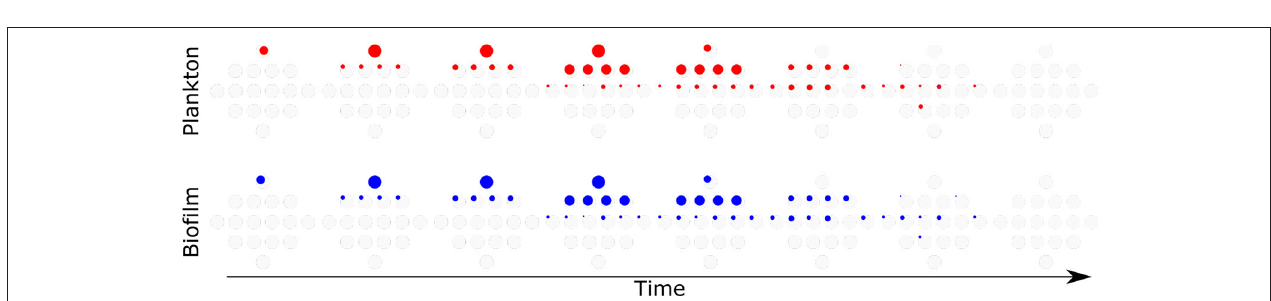
FIGURE 10 | No attachment and dispersal. Red—plankton, Blue—biofilm. From left to right—time, population composition is analyzed every 24 h. The diameter of the colored circle is proportional to the log 10 size of the population. Light gray circles are placeholders for various genotypes, with a diameter corresponding to the carrying capacity of the environment.